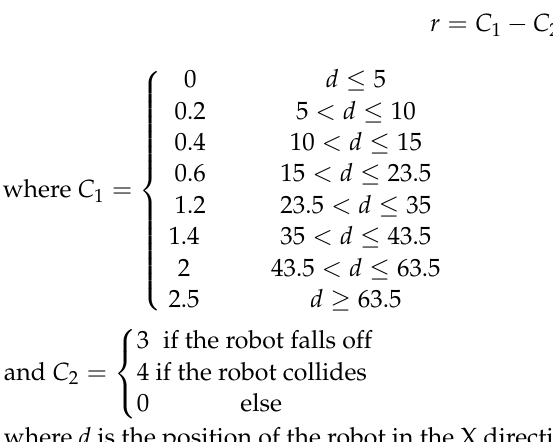
Figure 7. Terrain